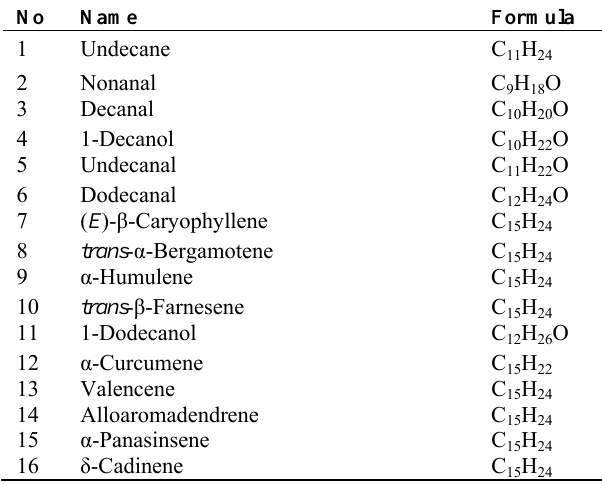
Table 3. The essential oil compounds found both in GC-MS and GC×GC–TOF